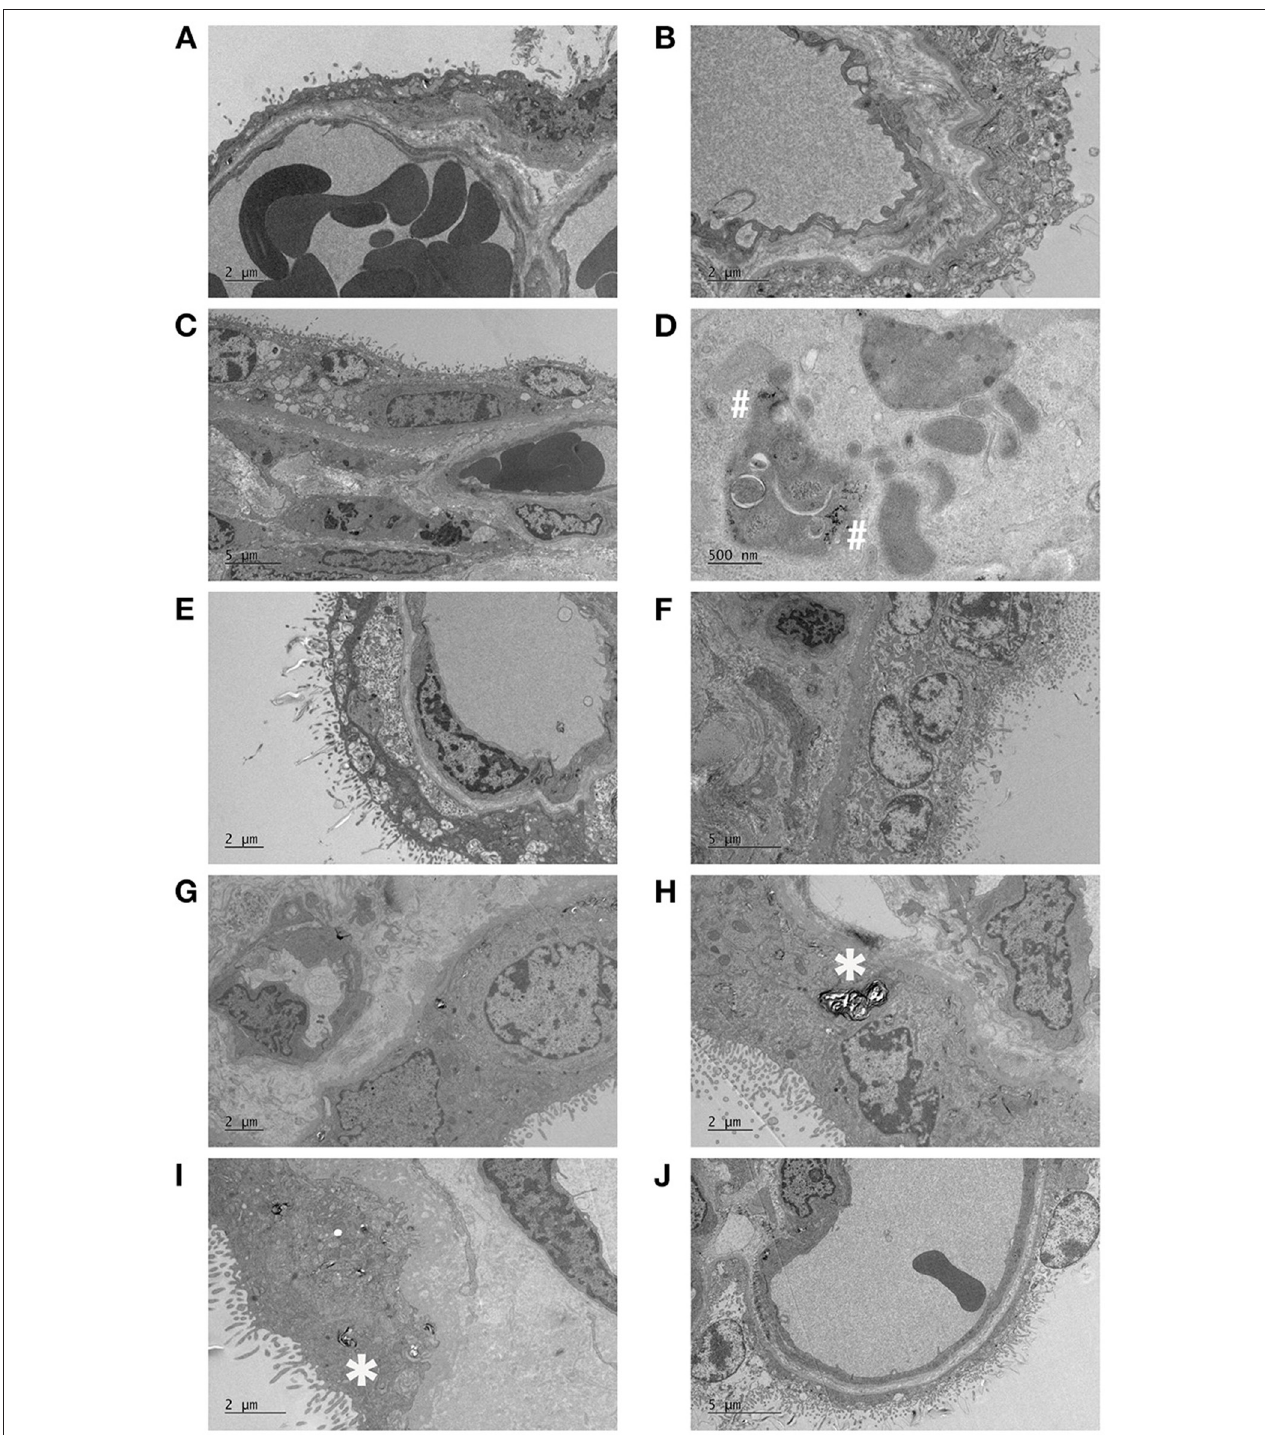
FIGURE 4 | Electron micrographs of placentas following maternal SARS-CoV-2 infection. Active COVID samples: (A) dilated cisternae of endoplasmic reticulum and sparce microvilli, (B) necrotic syncytium, (C) dilated syncytial endoplasmic reticulum, and swollen mitochondria, with multiple inclusions in an underlying Hofbauer cell and a multi-layered capillary basal lamina, (D) high power image of the ferritin particles within a Hofbauer cell inclusion. Post COVID samples: (E) large sub-apical vacuoles in the syncytiotrophoblast, (F) fibrotic stroma, thick basal lamina, malformed swollen villi, (G) small capillaries and (H) thickened basal lamina, swollen microvilli with possible loss of actin. Negative control samples: (I) numerous infoldings in the syncytial basal plasma membrane and thickened and cribriform basal lamina, with dispersed lamellar bodies (J) focal loss of microvilli (top right) and breakdown of the apical membrane and washed out syncytial cytoplasm (bottom left). The vasculosyncytial membrane appears relatively normal. *Indicates lamellar bodies, # indicates ferritin particles.